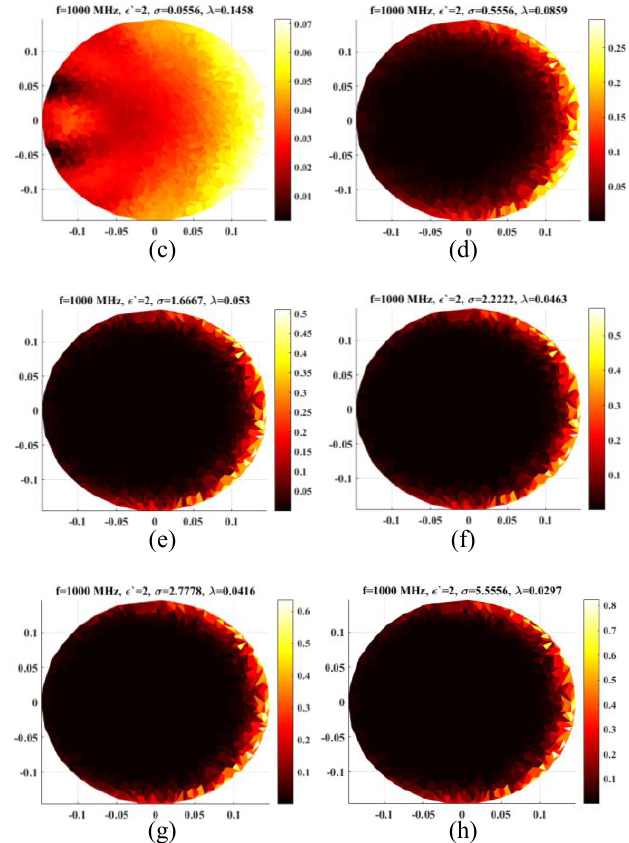
Figure 7: Distribution of fields on a scatterer with constant real dimensions as 𝜎 increases. (a) 𝜎 = 0, (b) 𝜎 =